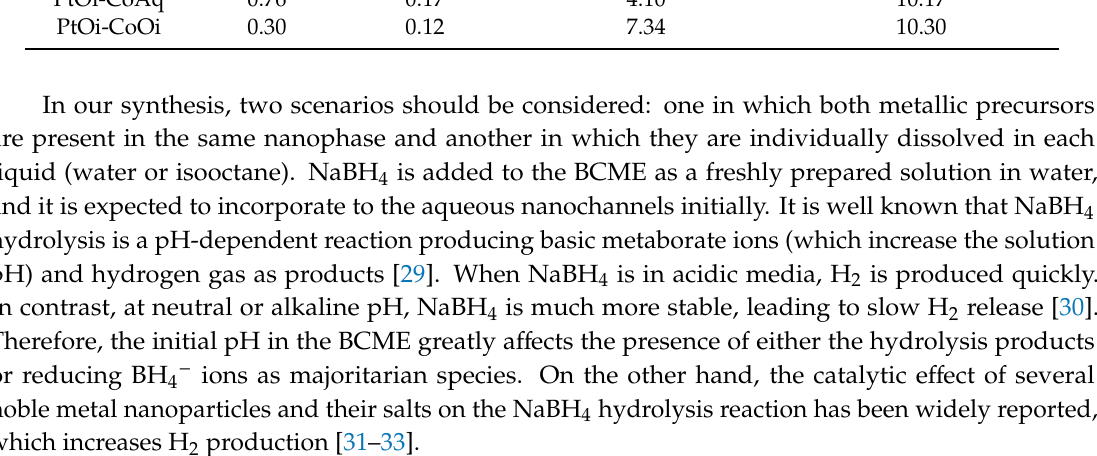
Table 1. Nominal and experimental Pt / Co mole ratios; pH of BCME before and after NaBH 4 addition. Pt / Co Mole Ratio pH BCME Sample Experimental Before NaBH 4 Addition After NaBH 4 Addition Nominal (ICP-AES) PtAq-CoAq